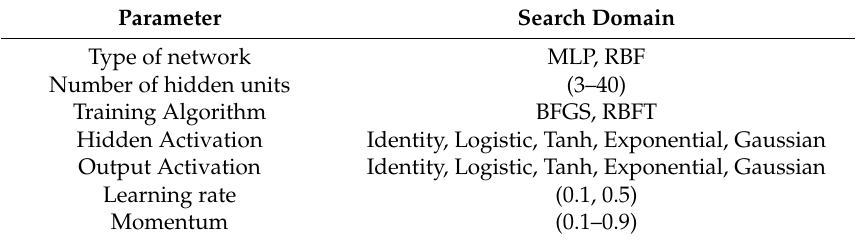
Table 3. Hyper parameters of the proposed model for traffic CO prediction and their search spaces used for